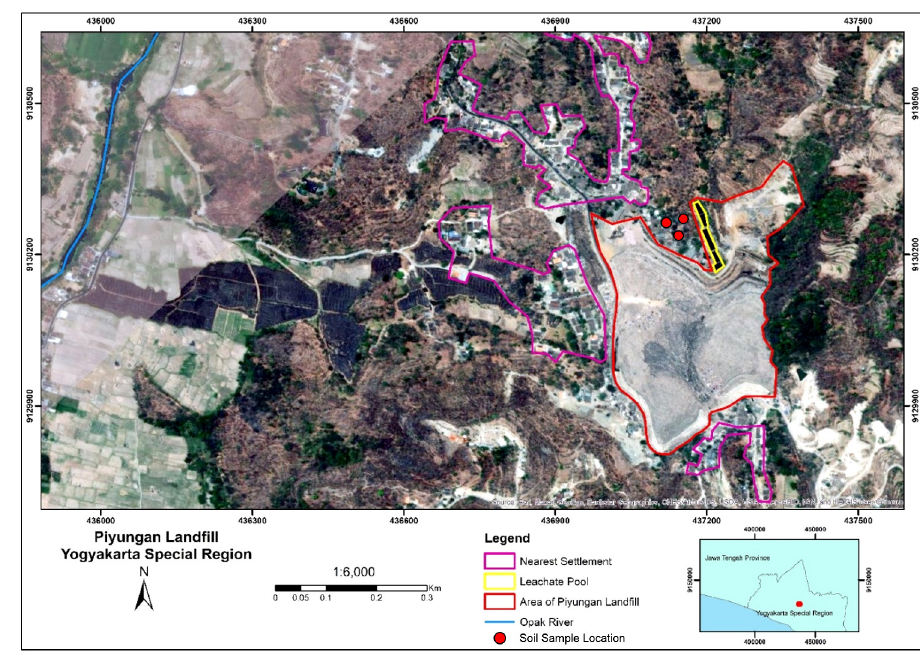
Figure 1. Location of the study area in Special Region of Yogyakarta,